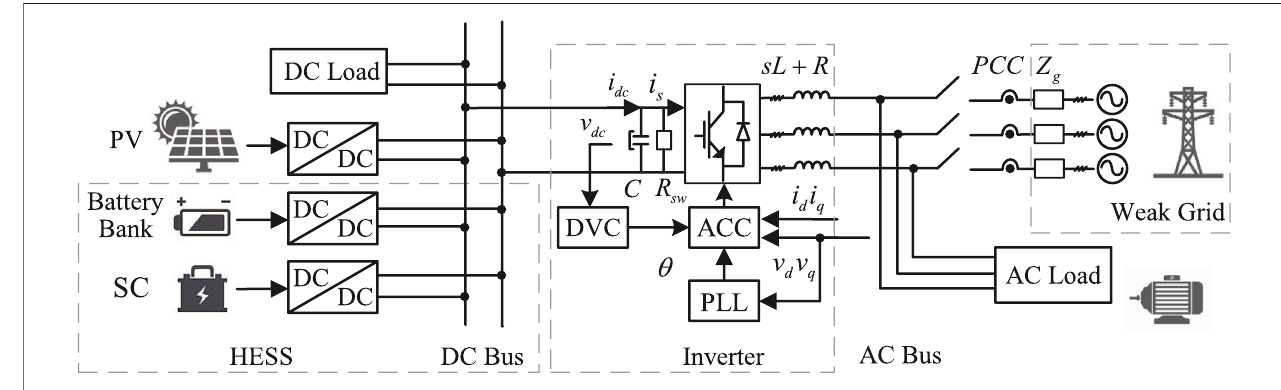
FIGURE 1 | Grid-connected PV and energy storage